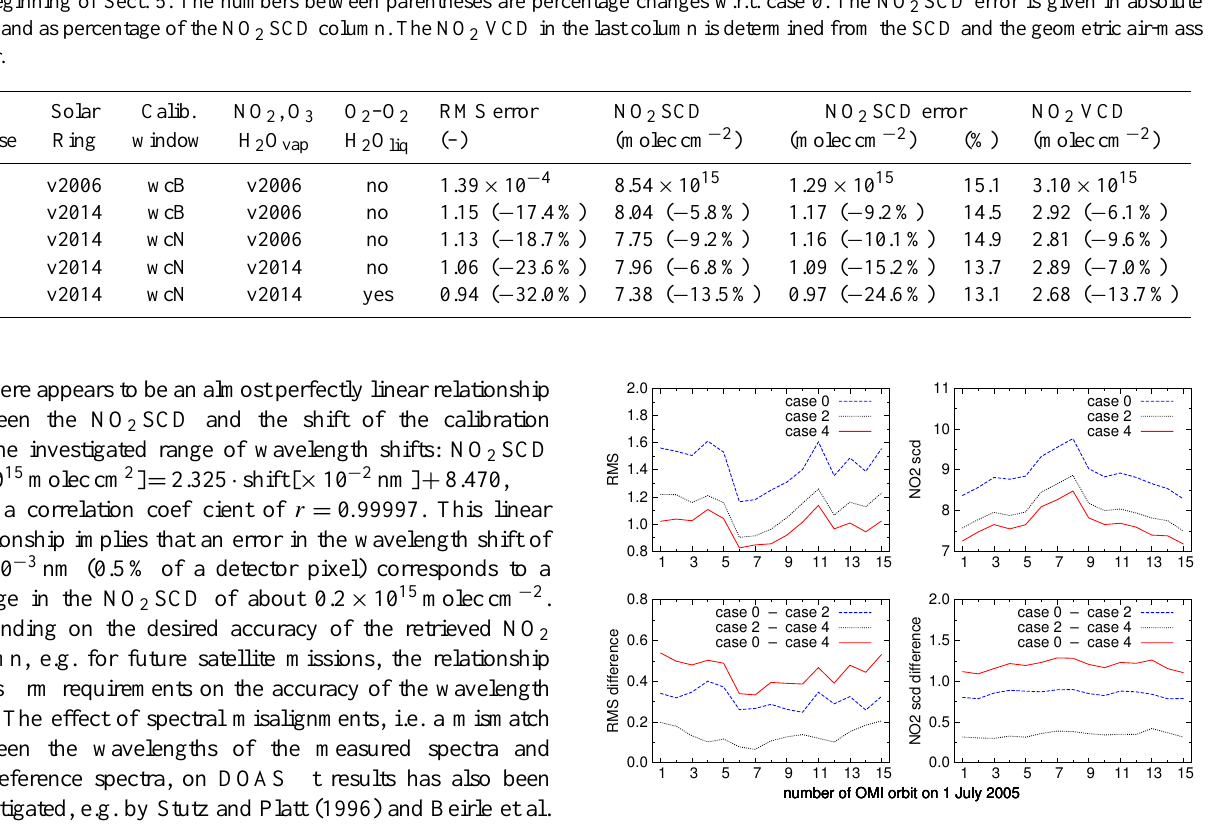
Figure 3. Absolute values (top row) and absolute differences (bot- tom row) of the orbit average RMS error (left column, × 10 − 4 ) and NO 2 SCD (right column, × 10 15 moleccm − 2 ) as a function of the OMI orbit number on 1 July 2005; the Pacific Ocean orbit is num- ber 14. The case numbers refer to the cases listed in Table 4. The difference “case 0 – case 2” (blue line) refers to the updates of the wavelength calibration, “case 2 – case 4” (black line) to the updates of the reference spectra, and “case 0 – case 4” (red line) to all up- dates put